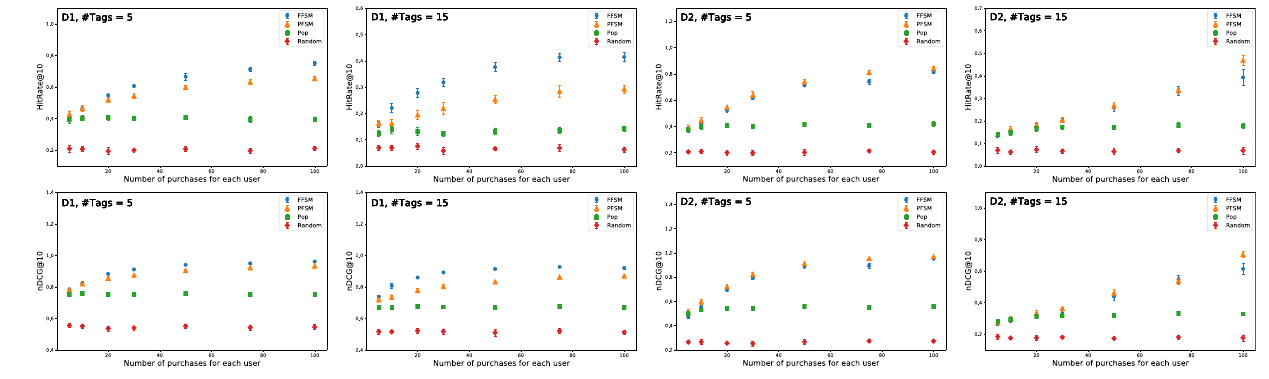
Fig. 3 Performance regarding sparsity